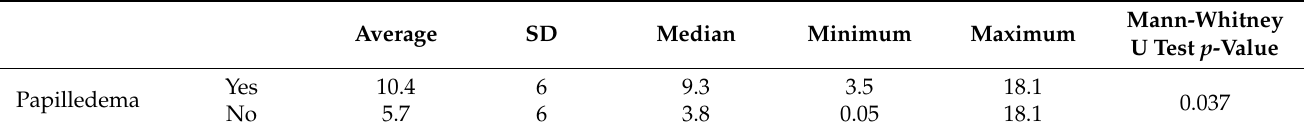
Table 6. Comparison of the presence of papilledema according to the